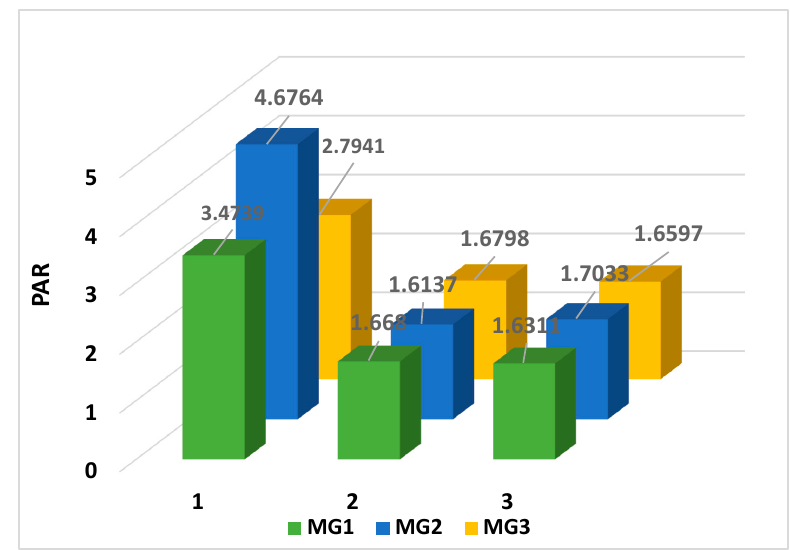
rized in Figure 31.